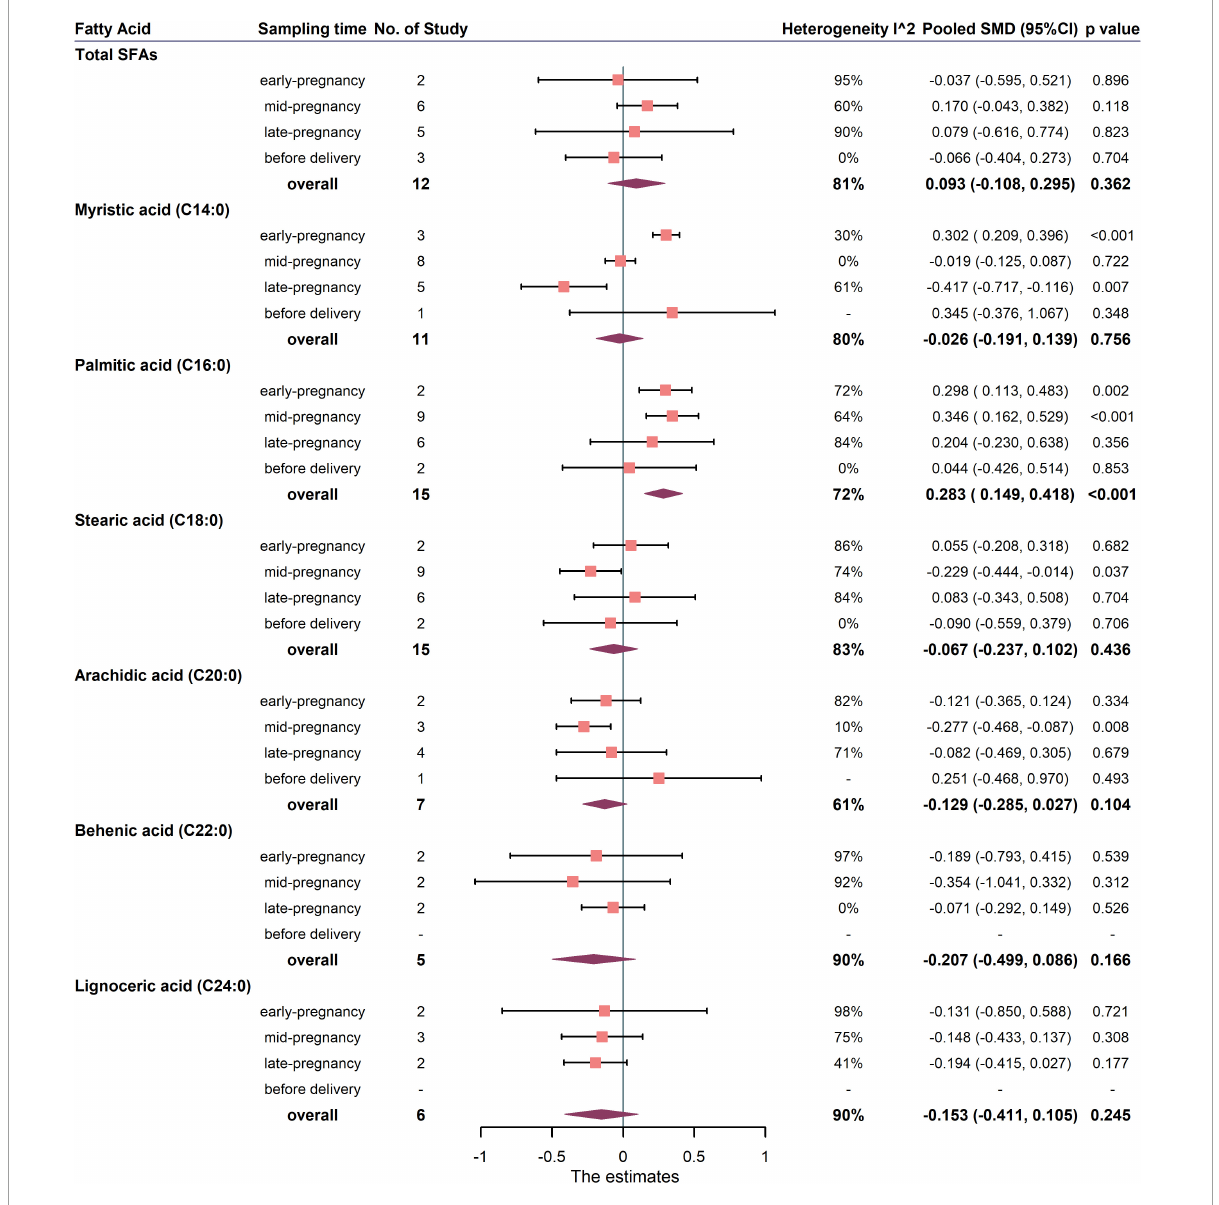
FIGURE3 Summary forest plot of pooled SMDs for total SFAs and each SFA as percentage of total fatty acids in pregnant women with and without GDM. Dots and horizontal lines represent SMDs and 95% CIs. Diamonds depict pooled estimates. The forest plots of the original studies were shown in the Supplementary Figure 2